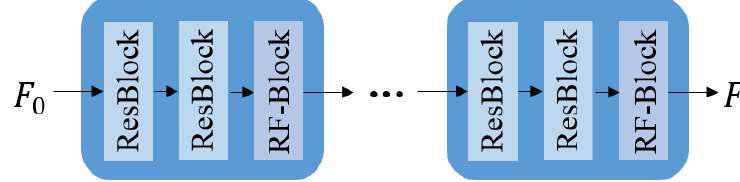
Figure 4. The structure of the base module